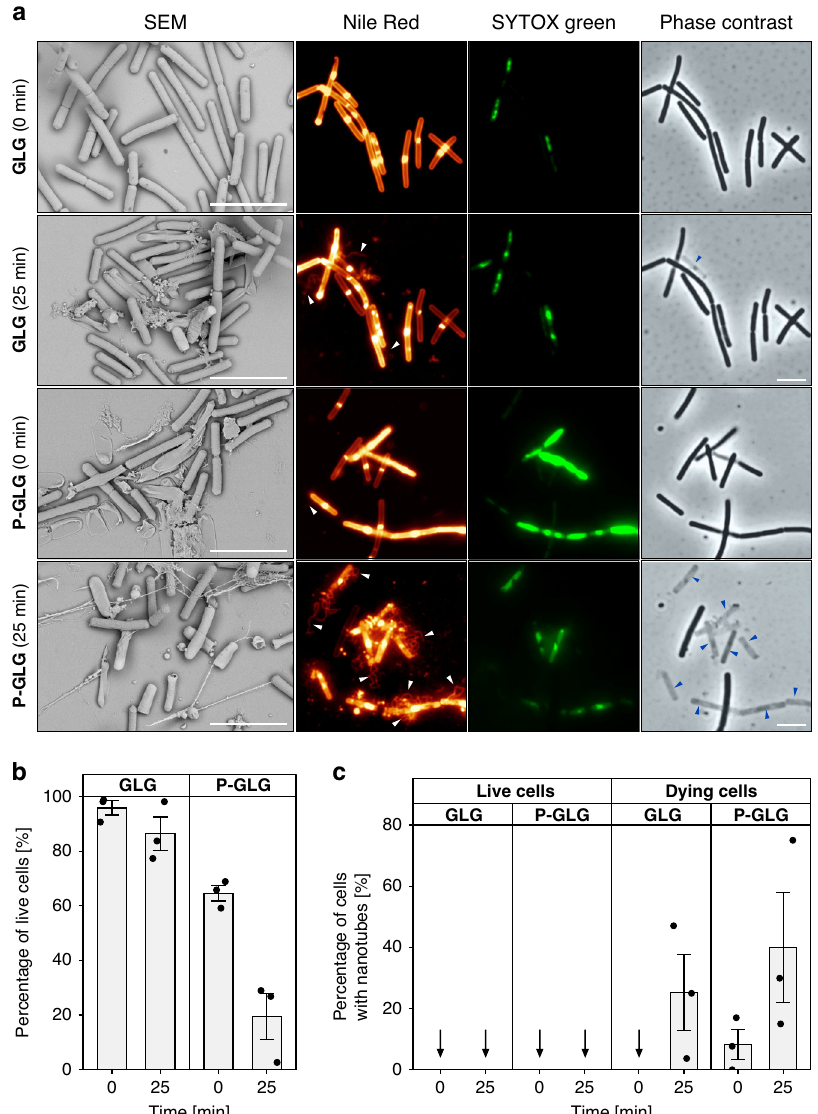
Fig. 2 Effect of coverslip pressure on NT formation. a SEM-exponentially growing B. subtilis Δ hag (LK1966) cells spotted on an uncoated glass slide and covered with a poly- L -lysine coverslip. The coverslips were either gently positioned over the sample (the GLG method) or pressed down (the P-GLG method). t = 0, the coverslip, after being positioned over the sample, was immediately removed (for SEM), or the sample, still with the coverslip, was immediately imaged ( fl uorescence microscopy); t = 25, the same with t = 0 but the coverslip was left over the sample for 25 min. Before SEM, bacteria were fi xed. For fl uorescence microscopy, non- fi xed living bacteria (LK1432-wt) were observed. White arrows indicate NTs, blue arrows indicate ghost cells. Membranes were stained with Nile Red (false colored glow). Dying cells were monitored with SYTOX green (green). Scale bars in all images represent 5 μ m. All experiments were conducted in three biological replicates with similar results. b Effect of sample preparation methods on bacterial viability. Low pressure (GLG) and high pressure (P-GLG) methods were compared at two different time points ( t = 0 and t = 25 min). Live and dying cells were quanti fi ed according to the presence or absence of the SYTOX signal within the cells. We note that among live cells may be also those that are actually dead and intact, impenetrable to SYTOX. Signi fi cantly fewer live cells were observed by P-GLG (at both times) than by GLG ( p < 0.001, GLM, two-sided, z = − 10, 95% CI OR = 0.02 – 0.08) and at the later time points for both methods ( p < 0.001, GLM, two-sided, z = − 4, 95% CI OR = 0.12 – 0.45). For both conditions, a total of 400 cells from three independent experiments were analyzed (the black dots represent individual replicates). The bars are averages and error bars ± SEM. c The presence/absence of NTs in samples that were prepared by two different methods (GLG or P-GLG method). Quanti fi cation of NTs was based on the Nile Red signal. The percentage of NTs is expressed relative to the number of dying (SYTOX positive) or live (SYTOX negative) cells, which was set as 100% (e.g., out of the 10% of dying cells, 20% formed NTs — that is 2% of the total number of cells). The P-GLG method of sample preparation (compared to GLG) resulted in larger amounts of dying cells with NTs at both time points ( p = 0.04, GLM, two-sided, z = 2.05, 95% CI OR = 1.2 – 16). No NTs were detected in live cells. For both conditions, 400 cells from three independent experiments were analyzed (the black dots represent individual replicates). The vertical arrows in the chart indicate values “ zero ” . The bars are averages and error bars ± SEM (standard error of the